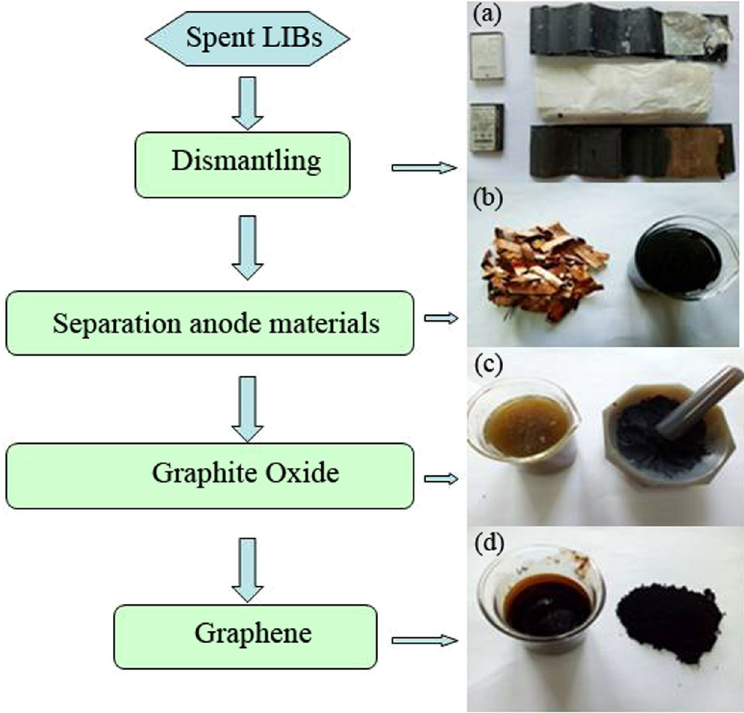
Figure 1. Preparation process of graphene production from spent lithium-ion